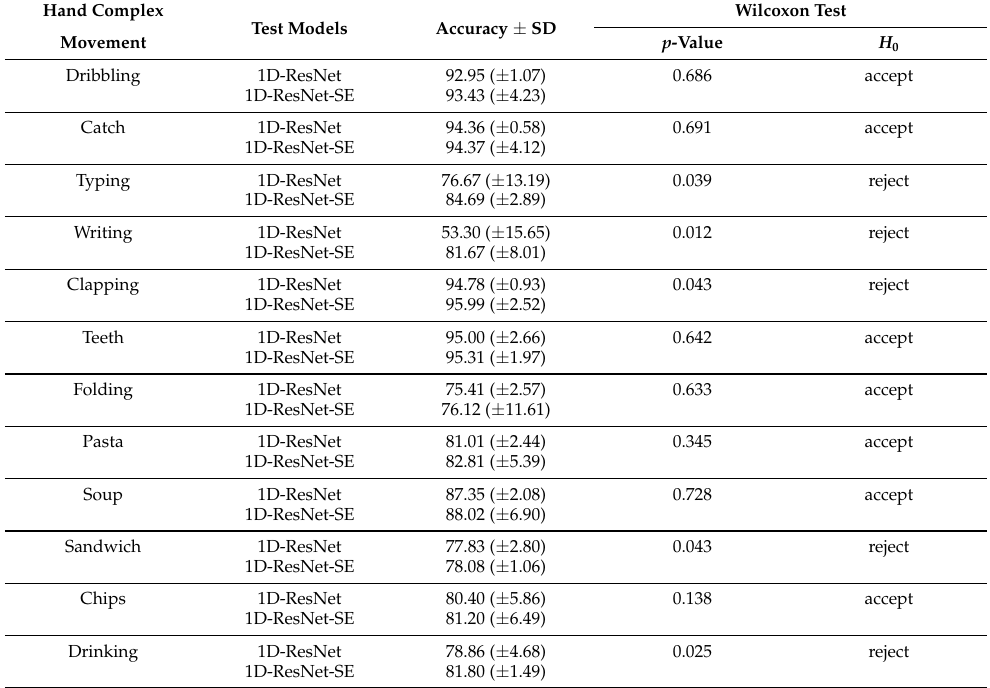
Table 9. Wilcoxon test based on the accuracy metrics for model performance comparison on the WISDM-HARB